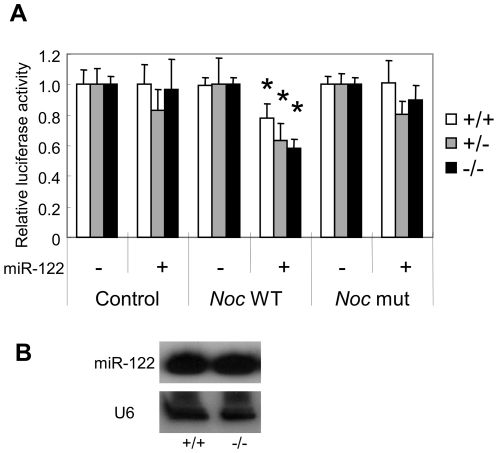
Deadenylase activity of Nocturnin was not involved in miR-122-mediated self-regulation.
A. Relative luciferase activities (means ± S.E. Three independent experiments in duplicate) with miR-122 overexpression in MEFs (White bars; +/+, Gray bars; +/−, Black bars; −/−). Luciferase activities were normalized as described in Figure 2. Asterisks represent p<0.005 versus no miR-122. B. miR-122 expression was measured from Noc
+/+ and Noc
−/− livers. RNA samples are pools of equal amounts of RNA from each circadian time point (ZT 0, 4, 8, 12, 16, and 20, one mouse per time point).